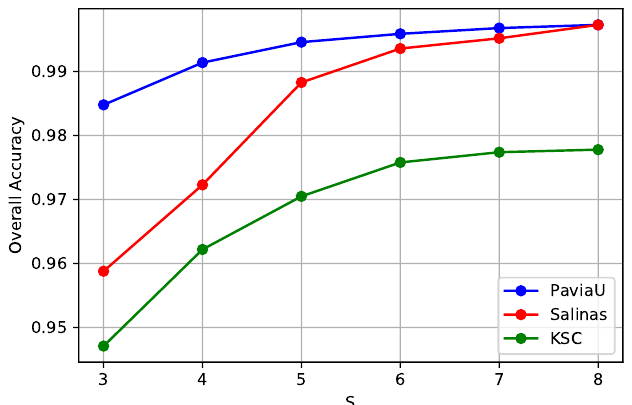
Figure 7. The curves of OA obtained by different input scale numbers S for three HSI datasets. The OAs first arise with the increase of the input scale number S , and then become saturated for all three HSIs. Thus, we choose the scale number S = 8 for all the HSIs for our proposed